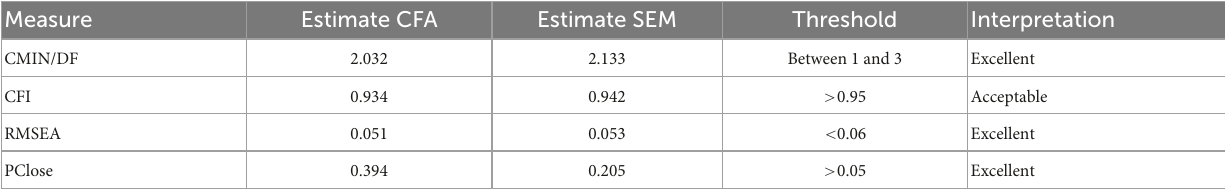
TABLE 3 Confirmatory Factor Analysis (CFA) fitness